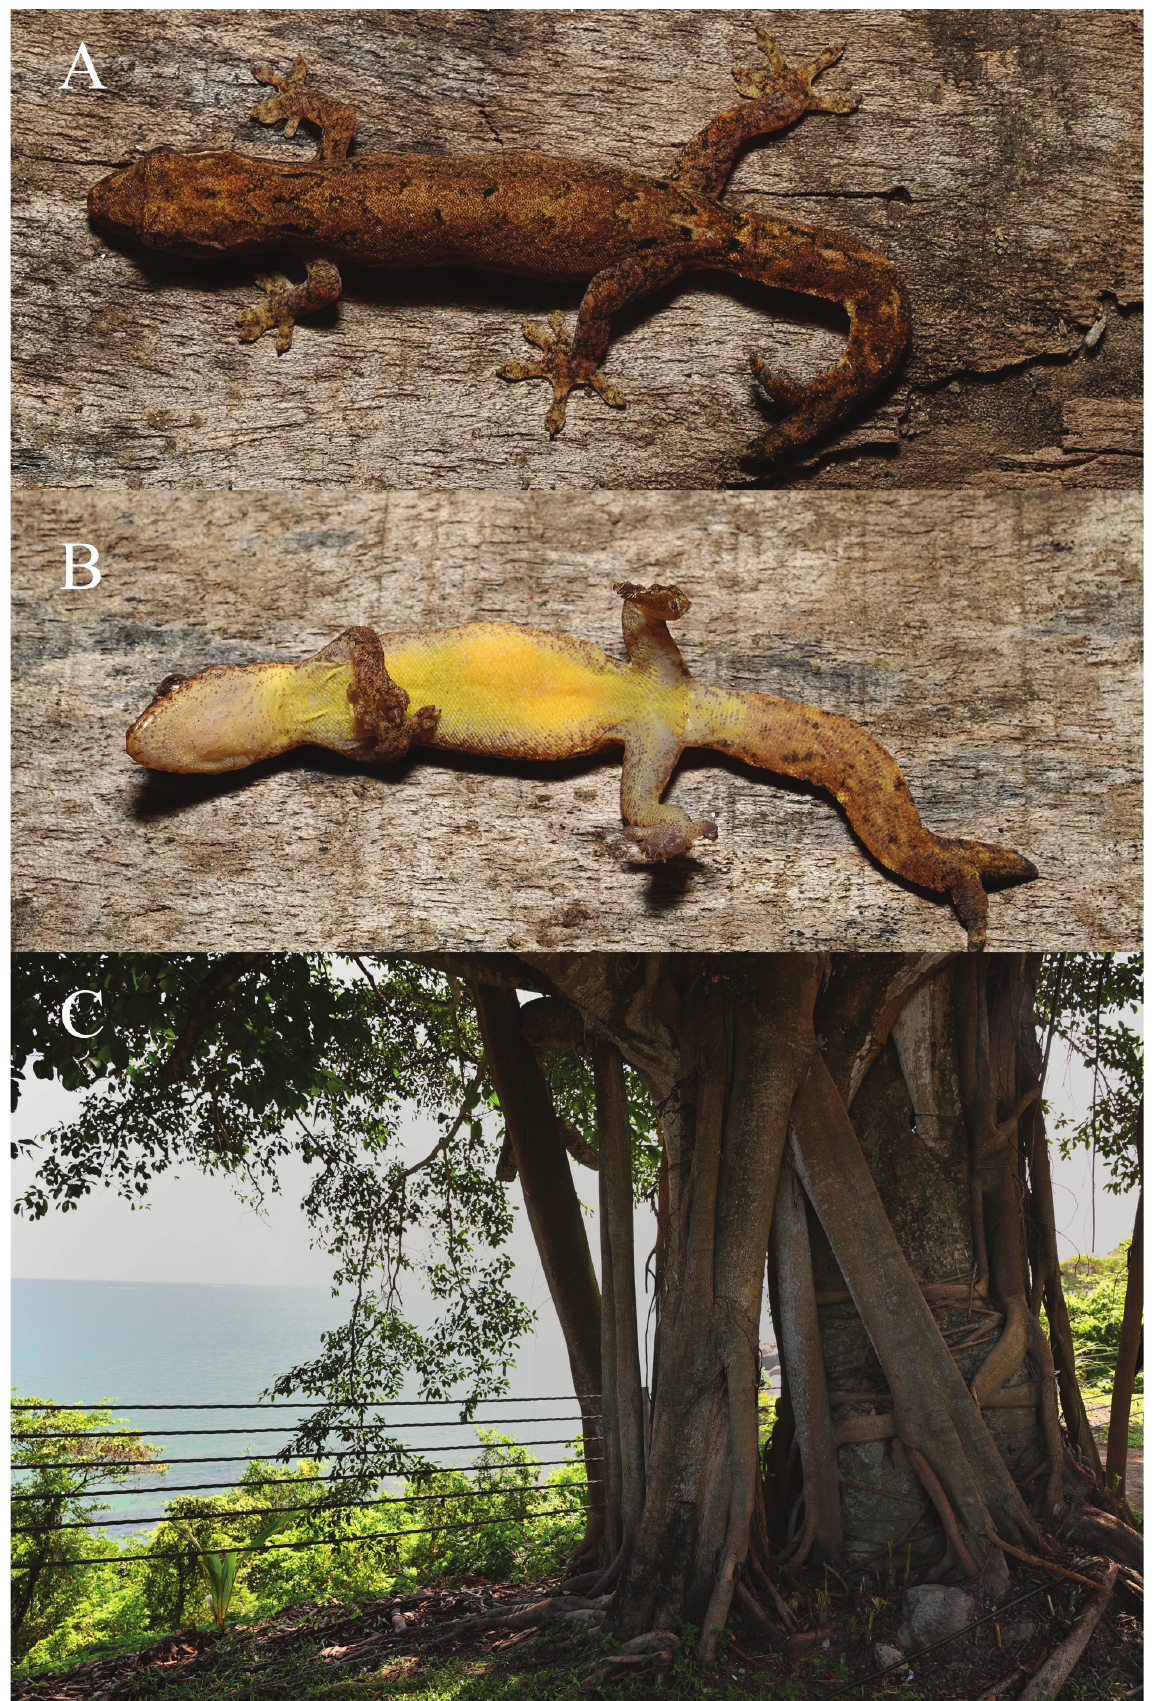
Figure 2. The specimen (SYNU210417) collected from Shimei Gulf, Wanning City, Hainan Province, China in life and its micro habitats. A. Dorsal view; B. Ventral view; C.